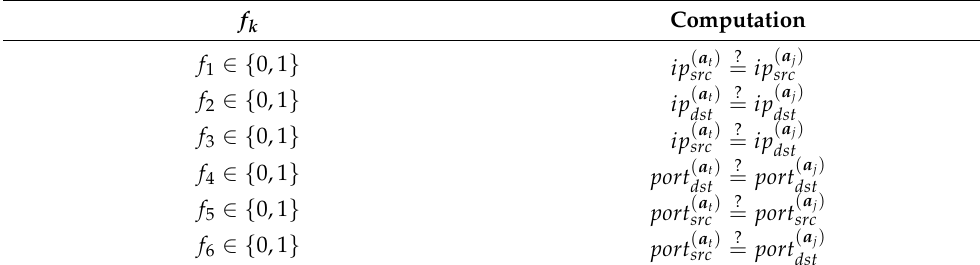
Table 3. The proposed comparison functions f k to compute the similarity between alert a t and a j , utilizing the alert attributes { ip src , ip dst , port src , port dst }